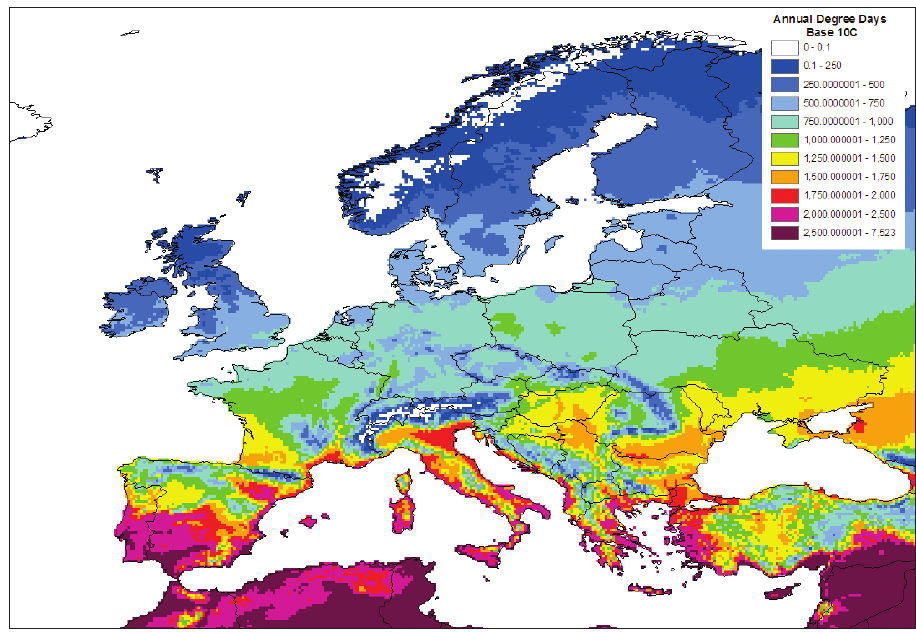
Figure 5. European Map of Temperature Accumulation (Degree Days). This map is based on a mini- mum threshold temperature for development of 10 °C, using 1961–90 monthly average maximum and minimum temperatures taken from the 10 minute latitude and longitude Climatic Research Unit data- base (New et al.